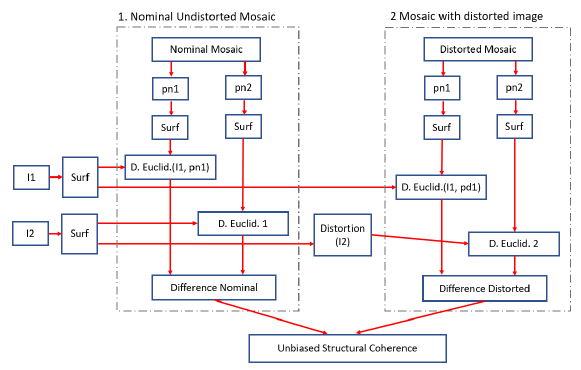
Figure 6. 10% highest response SURF ranked points extent of actual distorted contents transferred to the mosaic.